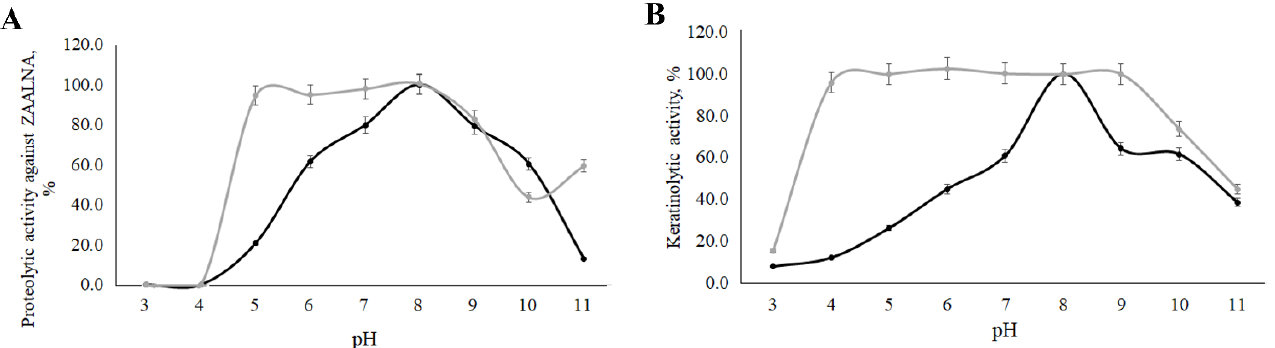
Figure 11. Activity of the Aspergillus clavatus VKPM F-1593 keratinase against ZAALNA ( A ) and keratin ( B ) dependency on pH: pH-optimum (black lines); pH-stability (grey lines).